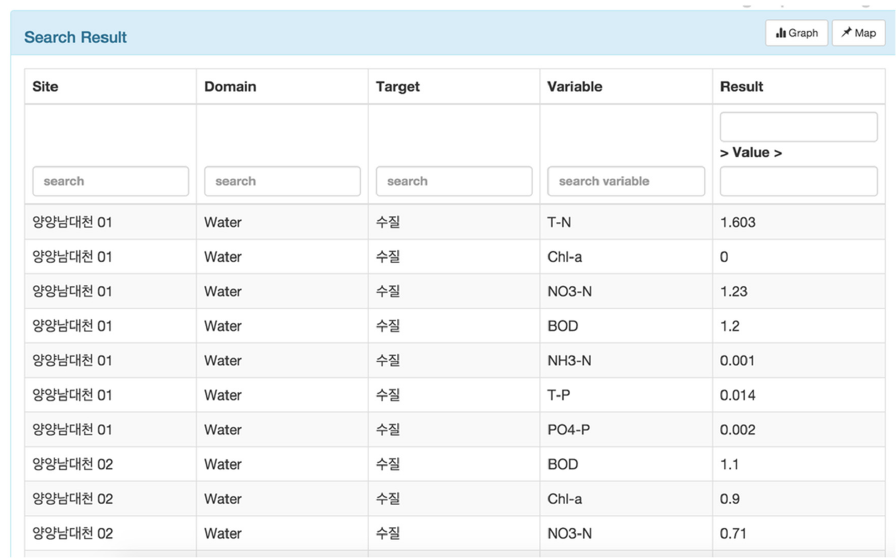
Figure 12. GUI window for the site-based observation data search.